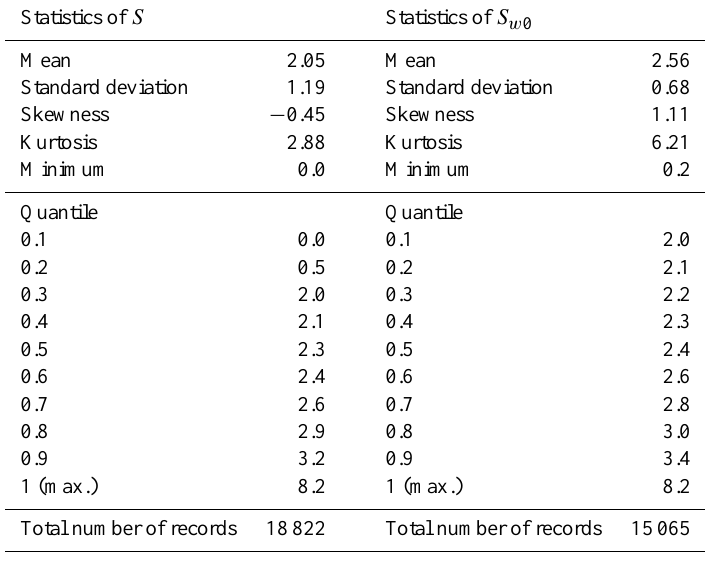
Table 4. Statistics of S and S w 0 .